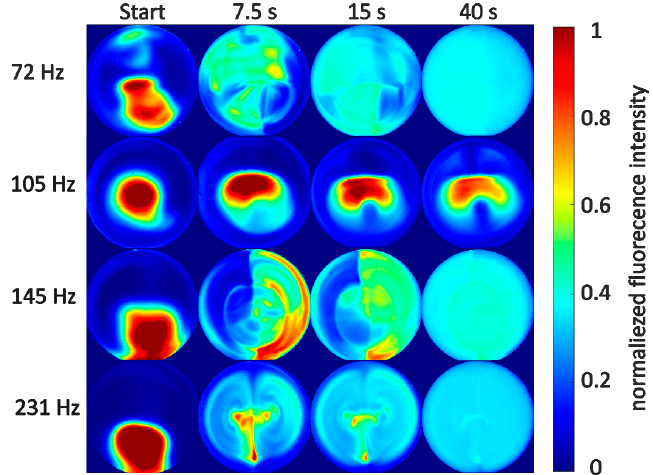
Figure 5. Exemplary LIF image series showing the normalized fluorescence intensity, indicating the qualitative concentration of 1 µL Rhodamine B during mixing in water within a GB-MBR with S = 50°. Shown image series correlates with frequencies calculated for the second, third, and fourth capillary wave resonances according to Equation (3). For comparison purposes, an image series for a frequency in between f 2 and f 3 is also shown. Volumetric power input P mix was set to 300 W · m − 3 . From left to right, images are taken at 0, 7.5, 15, and 40 s after start of excitation. The mixing at 𝑓 (cid:2871) and 𝑓 (cid:2872) seems to be driven by similar vorticity inside the GB-MBR: two vortices are formed, leading to mixing inside the GB-MBR. Similar vortices are described in other works investigating internal flow patterns induced by surface waves on droplets [14–17,40,41].